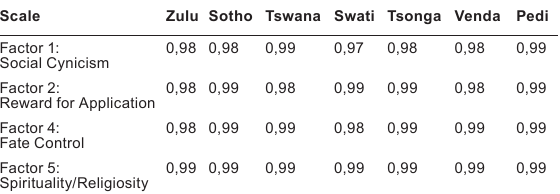
Kind-hearted people are easily bullied. People deeply in love are usually blind.